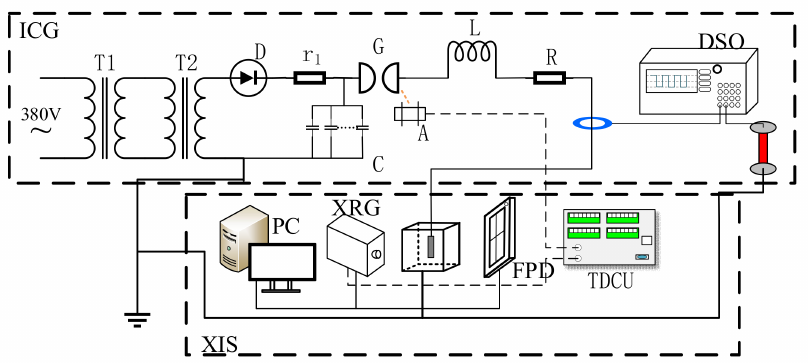
Figure 1. Impulse discharge and X-ray imaging test wiring diagram.